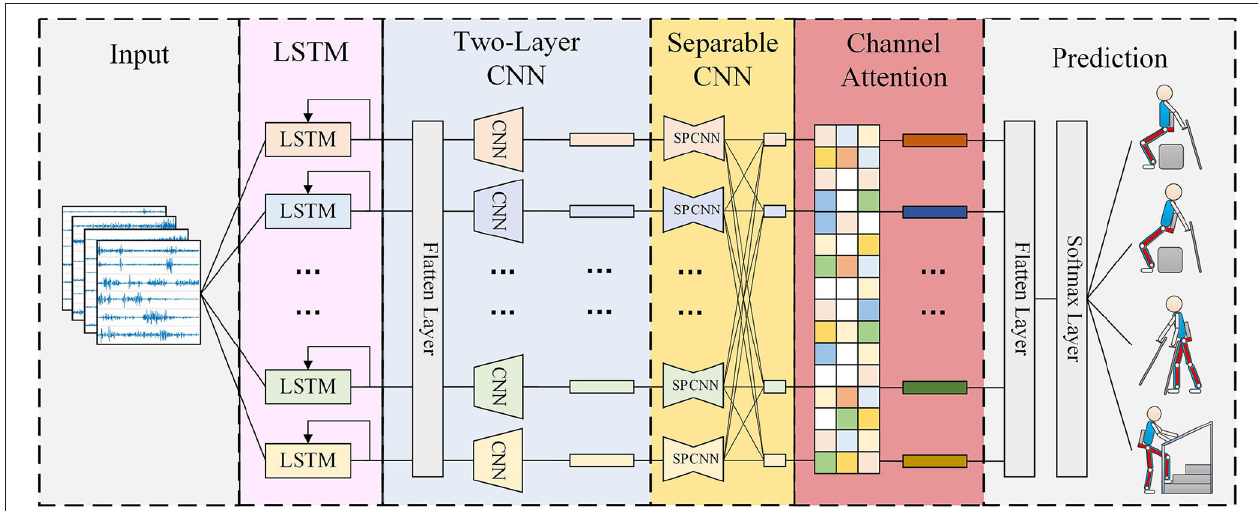
FIGURE 1 | Overall architecture of the MCSNet model. Lines denote the convolutional kernel connectivity between inputs and outputs (called feature maps). The network starts with a channel-by-channel long short-term memory networks (LSTM) (second column) to learn the timing feature, then uses a two-layer convolution (third column) to learn different spatiotemporal features. The separable convolution (fourth column) is a combination of a depthwise convolution followed by a pointwise convolution, which can explicitly decouple the relationship within and across feature maps and learns the synergy feature of surface electromyography (sEMG).